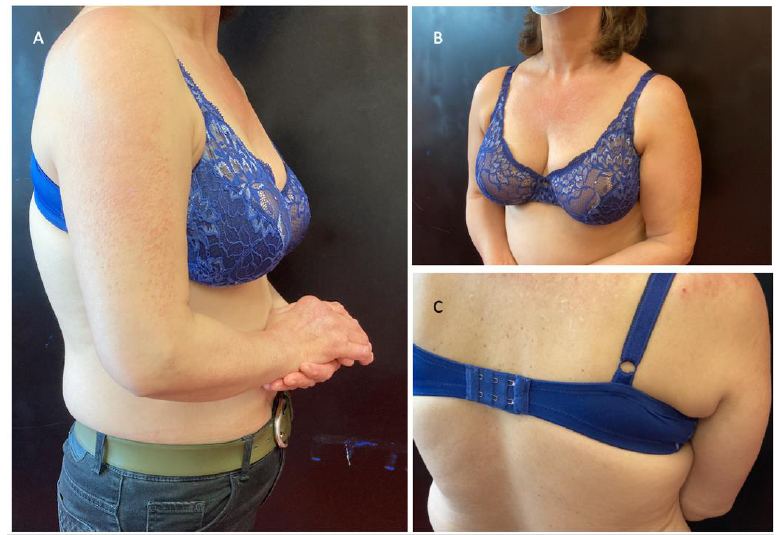
Figure 5. The patient after treatment with tocilizumab: the papules drastically reduced in number ( A ) and the erythema was less noticeable ( B , C ).